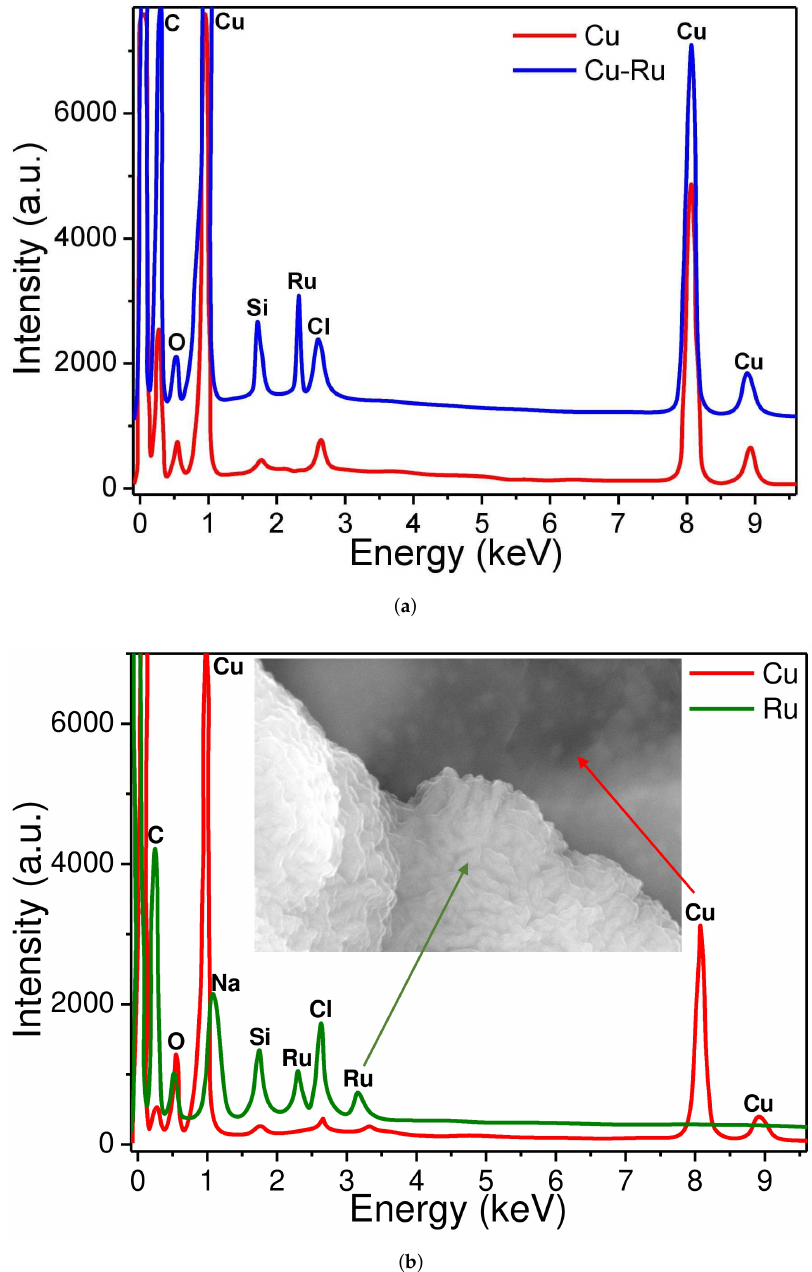
Figure 4. The results of X-ray microanalysis confirm the the elemental composition of Cu ( a ) and Cu–Ru ( b ) electrodes. One can see that Cu–Ru electrode consists of ruthenium islands located on top of copper (here, insert image is magnified SEM photograph Figure 3c, scale bar corresponds to 200 nm). The C, Na, Cl, O, and Si peaks correspond to the elements of the substrate material